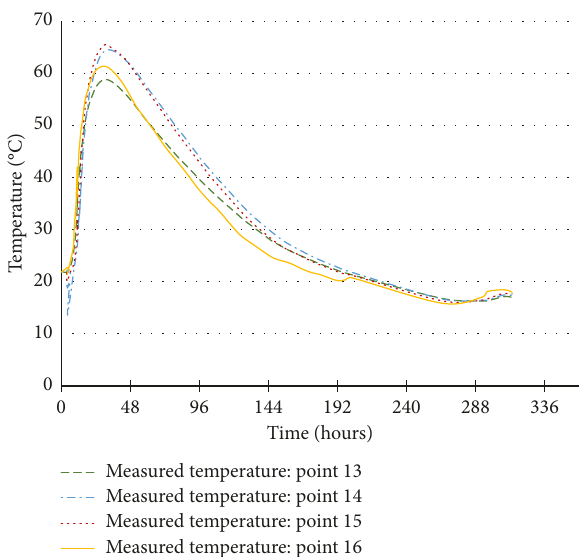
Figure 5: Measured temperature in the middle section (SV40).